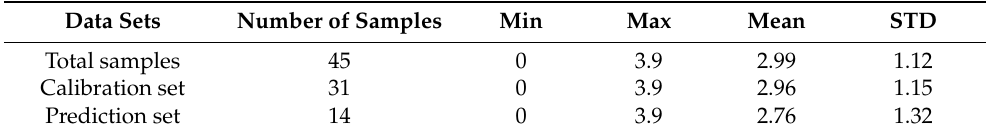
Table 4. Statistics on fat of milk samples.